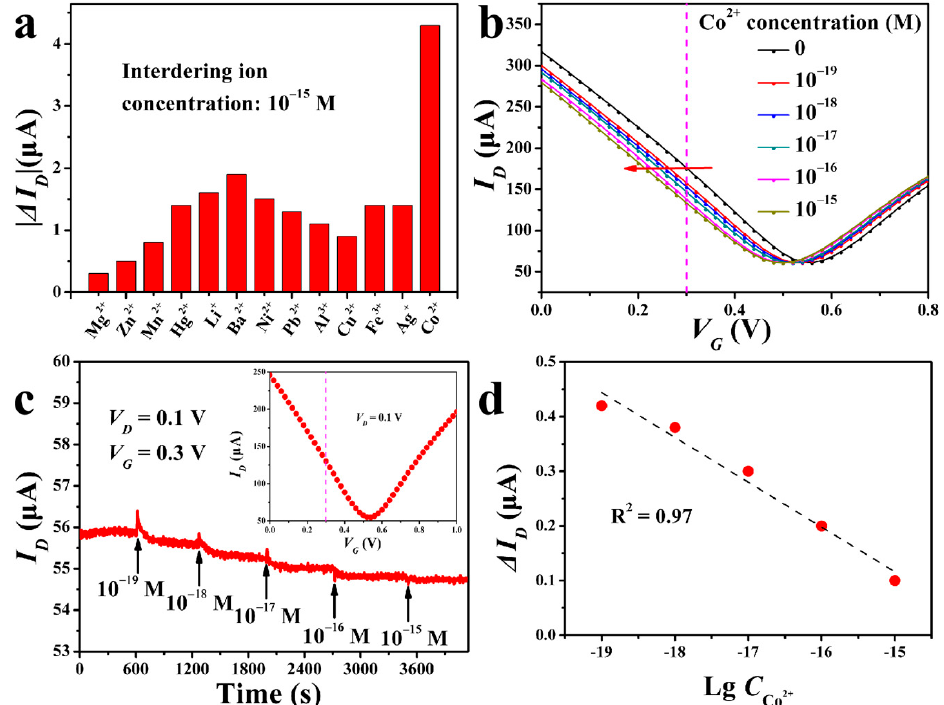
Figure 4. ( a ) Selectivity evaluation of the CD-SGGT sensor. Comparison of Co 2+ ions or other metal ions, i.e., Mg 2+ , Zn 2+ , Mn 2+ , Hg 2+ , Li + , Ba 2+ , Ni 2+ , Pb 2+ , Al 3+ , Cu 2+ , Fe 3+ , and Ag + (1.0 × 10 − 15 M); ( b ) the transfer curves at the different concentration of Co 2+ ; ( c ) channel current − time responses of the sensor at the different concentration of Co 2+ ( V D = 0.1 V, V G = 0.3 V). Inset: the corresponding transfer curves of the SGGT without the Co 2+ addition; ( d ) the ∆ I D versus the logarithmic value of Co 2+ ions concentration.